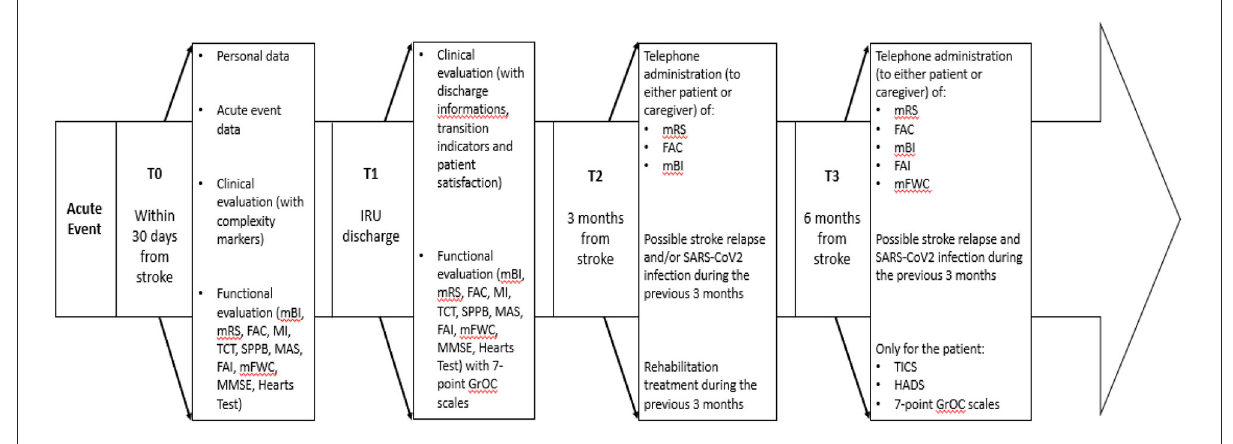
FIGURE1 Study timeline: Assessments conducted for each